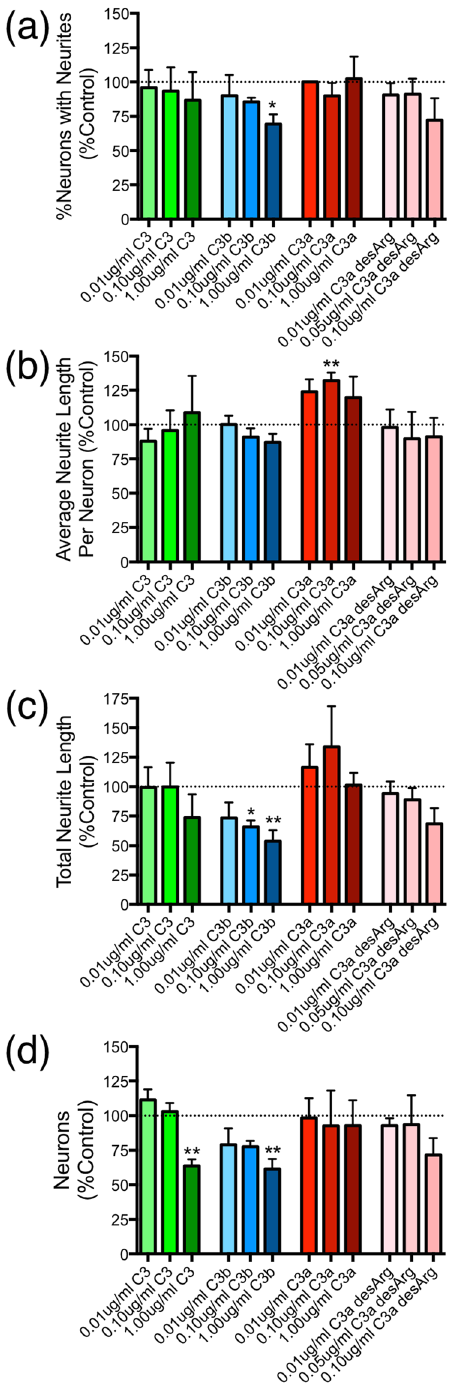
Figure 5. In the absence of myelin, complement C3b was growth inhibitory and promoted neuron loss in DRG cultures. Complement C3, C3a, or C3a desArg alone did not inhibit neurite growth. Quantification of ( a ) percent of neurite-growing neurons, ( b ) average neurite length per neuron, ( c ) total neurite length per image, and ( d ) number of β -TubulinIII + neurons are reported for each treatment: C3 (green bars), C3b (blue bars), C3a (red bars), and C3a desArg (pink bars) at 3 concentrations. Tested concentrations were: 0.01 μ g/ml (54 pM), 0.10 μ g/ml (540 pM), and 1.00 μ g/ml (5.4 nM) C3; 0.01 μ g/ml (57 pM), 0.10 μ g/ml (570 pM), and 1.00 μ g/ ml (5.7 nM) C3b; 0.01 μ g/ml (1 nM), 0.10 μ g/ml (56 nM), and 1.00 μ g/ml (111 nM) C3a; 0.01 μ g/ml (1 nM), 0.05 μ g/ml (5.6 nM), and 0.10 μ g/ml (11 nM) C3a desArg. Data is expressed as percent of the control wells from the same experiment, with Mean ± SEM. ANOVA with Dunnett’s post-test vs. control (dashed line), * p < 0.05, ** p < 0.01. N = 3–4 independent biological replicates per